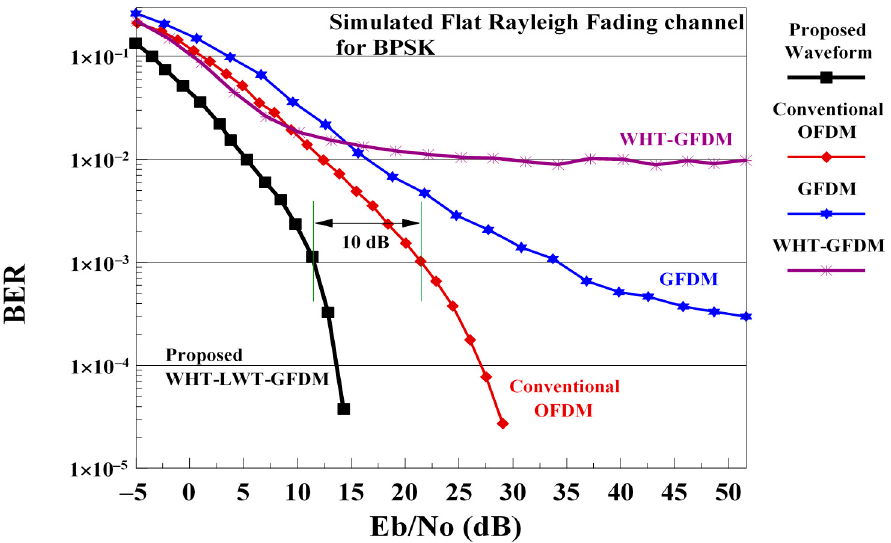
Figure 8. The BER-SNR comparisons of the traditional OFDM, GFDM, WHT-GFDM, and WHT-LWT-GFDM implemented using Haar mother wavelets waveforms on the flat Rayleigh fading channel.